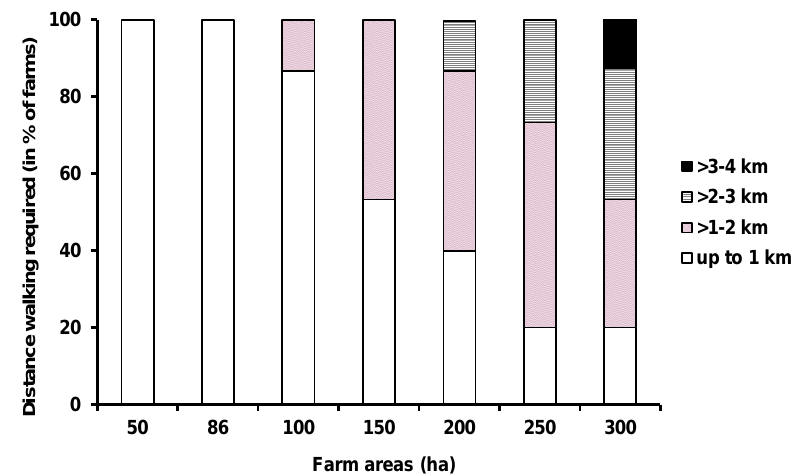
Figure 2. Walking distances (km) required by cows for different farm areas (legends show distances in